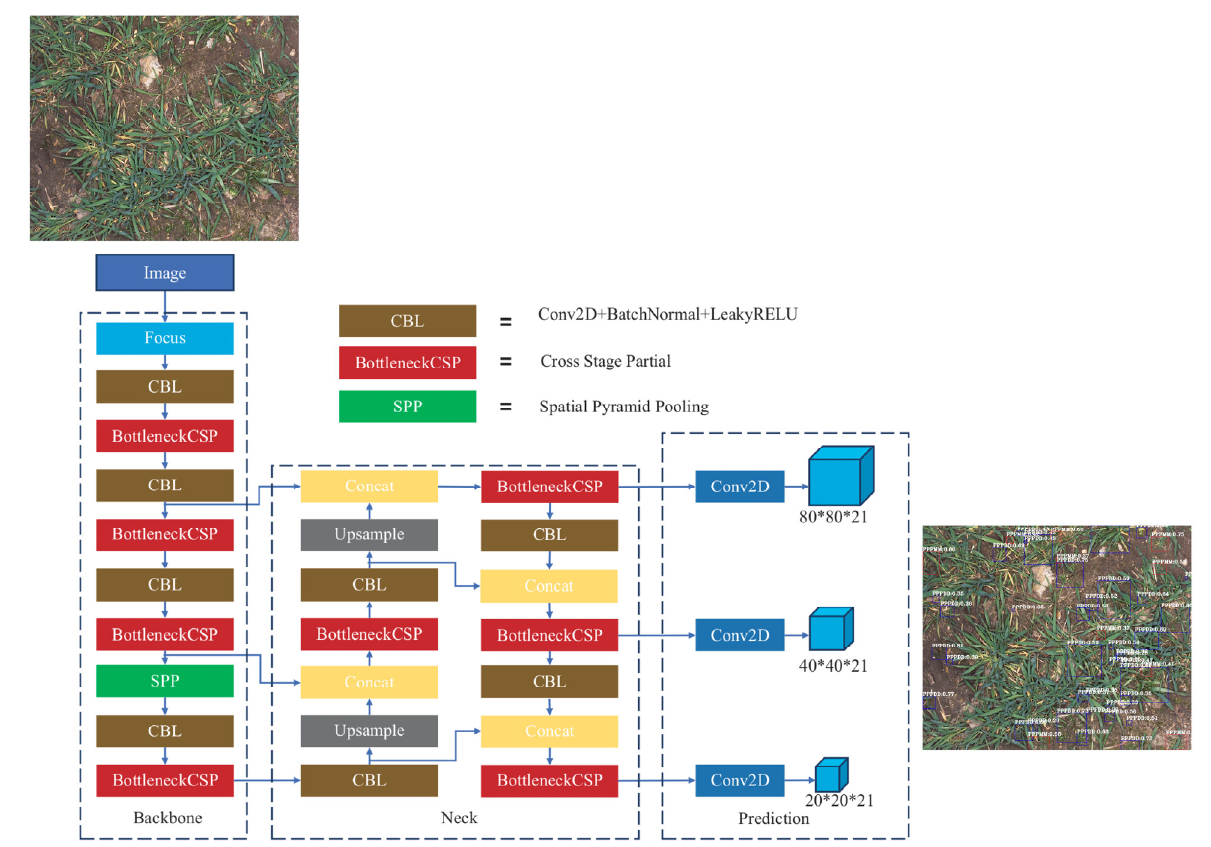
Figure 6. The YOLOv5 architecture [38].